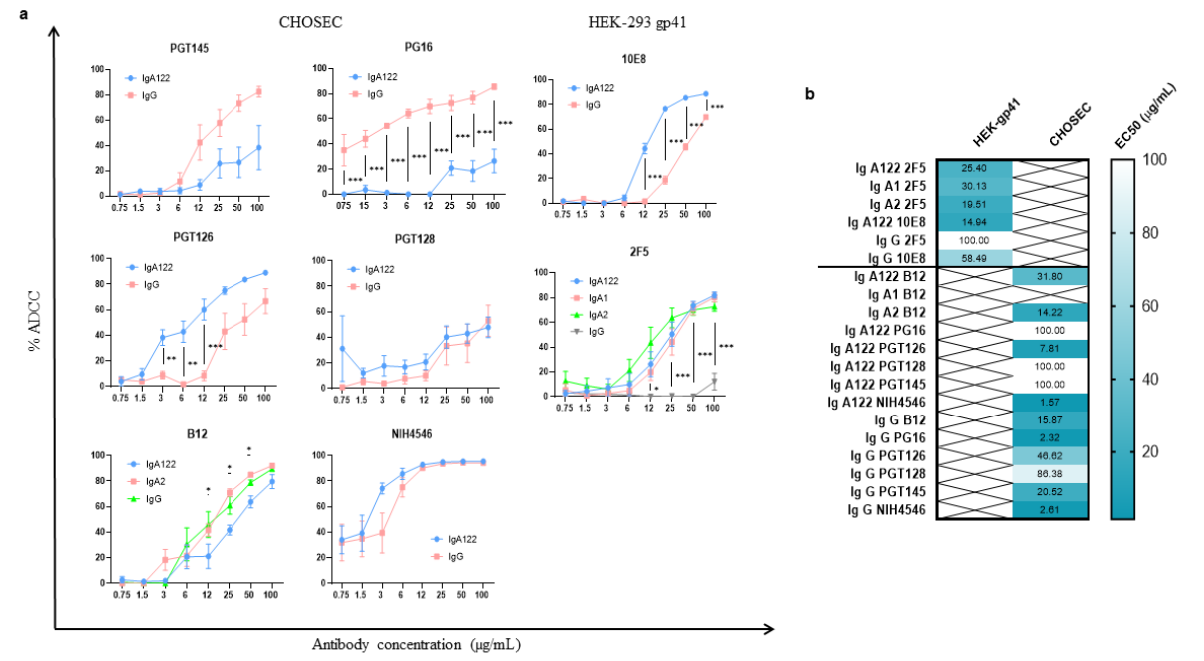
Figure 2. ADCC-like activities of bNAbs depend on their isotypes and their specificity: ( a ) %ADCC for each evaluated concentration. Each point represents the mean and SEM of triplicates from two different experiments. Student’s t-test was used for antibodies PGT145, PG16, 10E8, PGT126, PGT128, and NIH4546. A 2-way ANOVA with Tukey’s multiple comparisons was used for the antibodies 2F5 and B12. * p < 0.05, ** p < 0.01, *** p < 0.001 ( b ) Heatmap of EC50 ( µ g/mL) values obtained for ADCC. Numbers indicate the geometric mean values of results from triplicates of at least two independent experiments (n = 6).